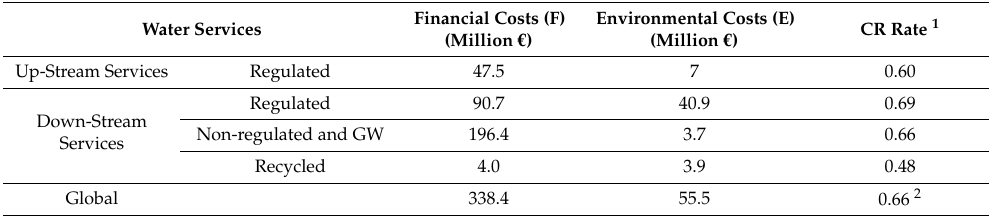
Table 5. Estimations of financial (F) and environmental (E) costs (total EACs) by water service and CR